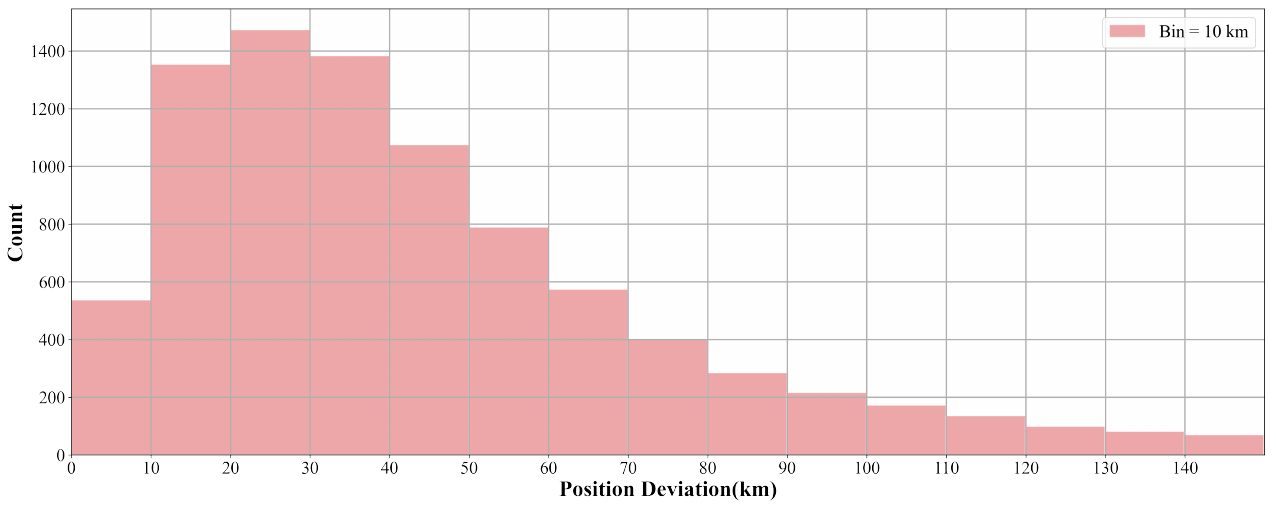
Figure 2. Histogram of position deviation of the representation in ERA5 with respect to